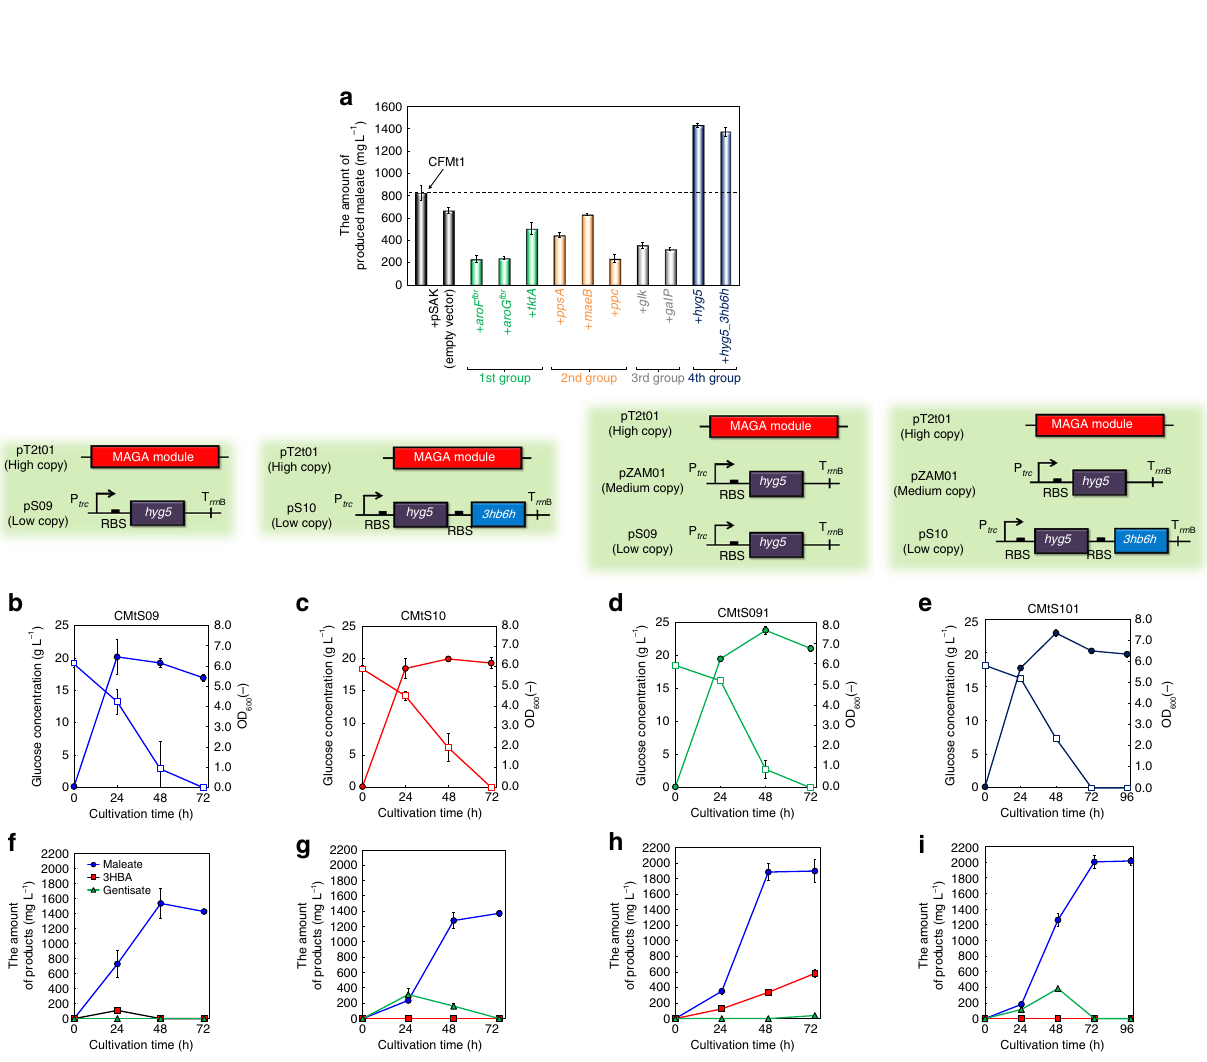
NATURE COMMUNICATIONS | 8: